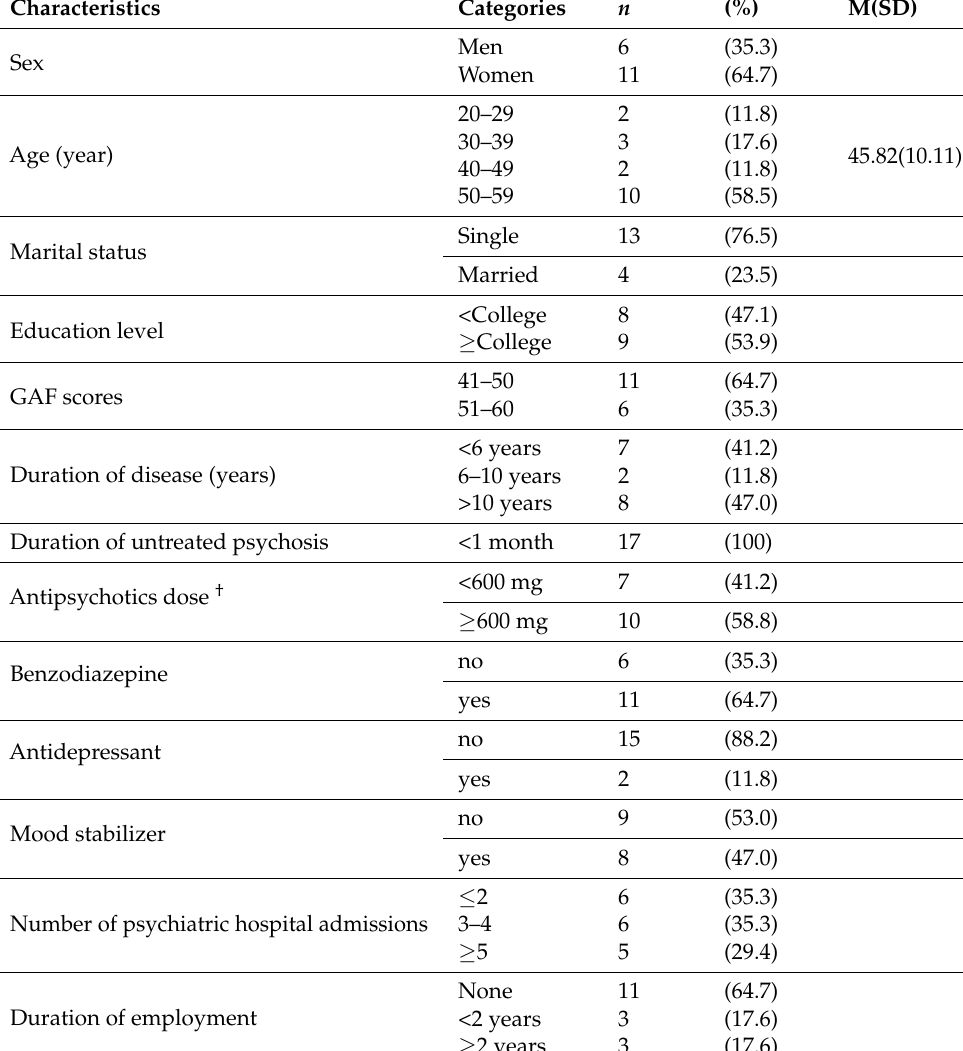
Table 2. Participants’ general and disease-related characteristics ( n =